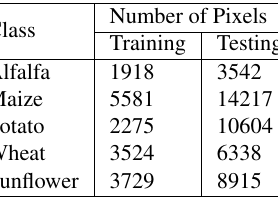
Table 3. Training and Testing